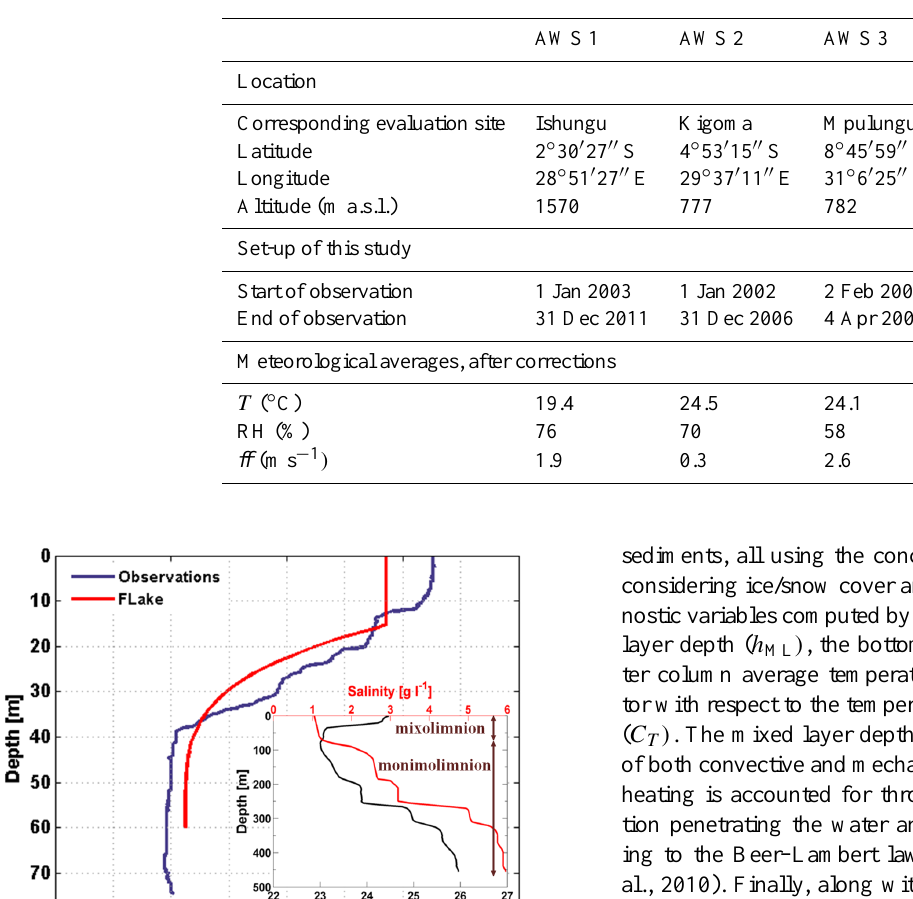
Table 1. Automatic Weather Station (AWS) topographic and meteorological characteristics.